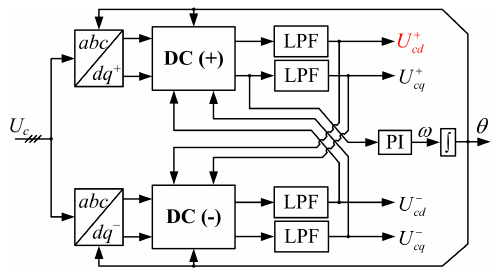
Figure 4. Equivalent control block of grid current. If the transfer function of the additional positive feedback loop is changed, the grid current quality and system stability might be changed under weak grid conditions. Therefore, this paper proposes a method based on DFPS-CVFF to suppress the inrush current, while also improving the grid current quality and system stability under weak grid conditions. The d -axis fundamental